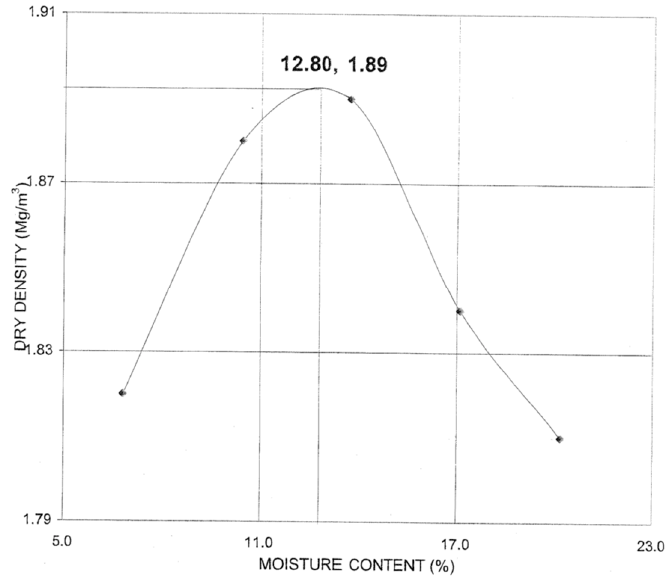
Figure 2. Typical sabkha compaction curve.